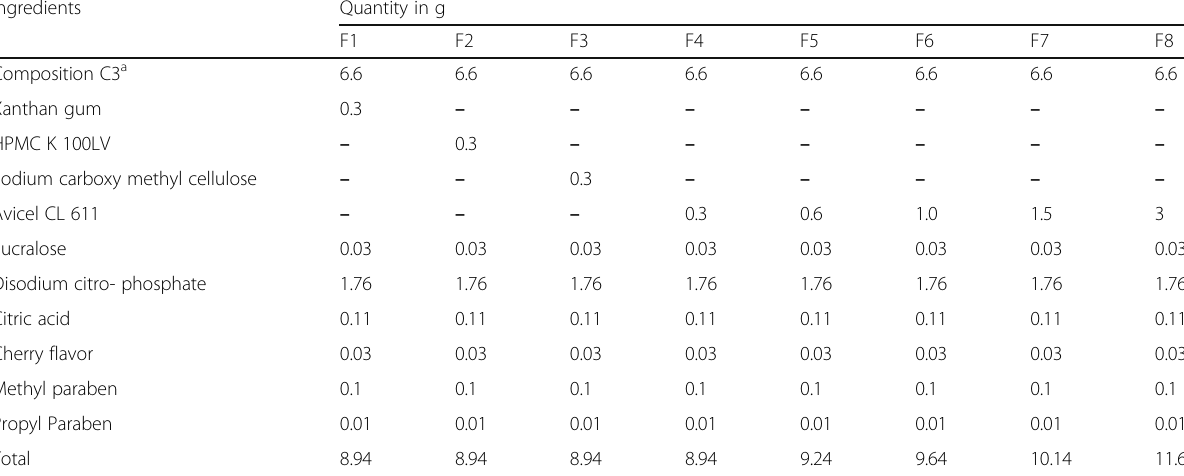
Table 2 Trials for the development of dry syrup formulation of coated KCl composition